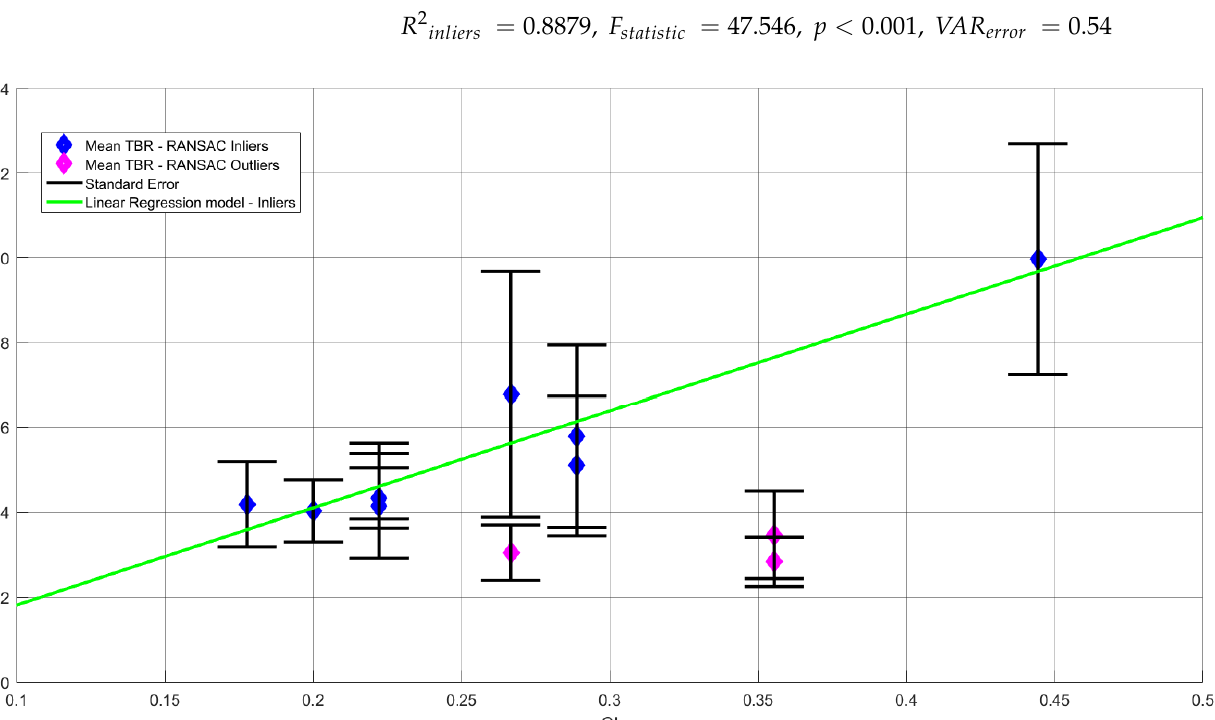
Figure 2. Quadratic regression model.